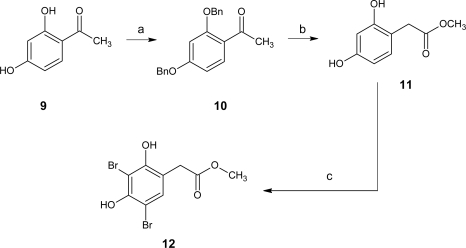
Synthesis of compound 12.Reagents and conditions: (a) potassium carbonate, benzyl bromide, acetone, 15 h, rt, 73%; (b) perchloric acid, thallium trinitrate, THF/MeOH (1/5), 18 h, rt then palladium 10% on carbon, ammonium formate, MeOH, 4 h, rt, 51% two steps; (c) N-bromosuccinimide, p-toluenesulfonic acid, MeOH, 3 h, 40 °C, ultrasonic bath, 73%.